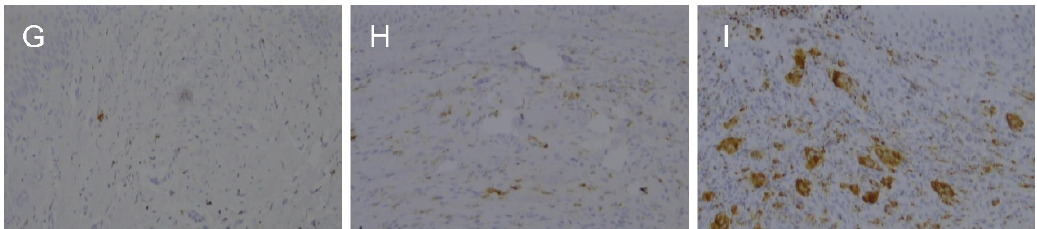
Figure 5. Expression of CD68 in the rat palate tissue after 3 days ( A – C ), 7 days ( D – F ), and 14 days ( G – I ). Scalpel ( A , D , G ), laser A ( B , E , H ), and laser B ( C , F , I ).